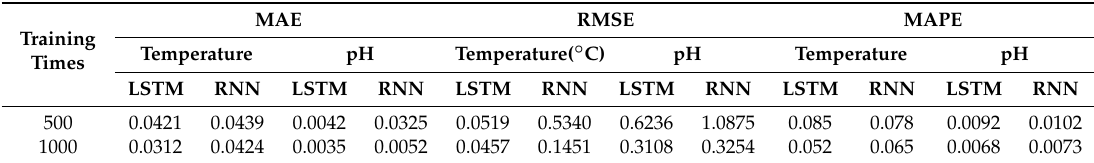
Table 6. Records of MAE, RMSE, and MAPE in long-term prediction.